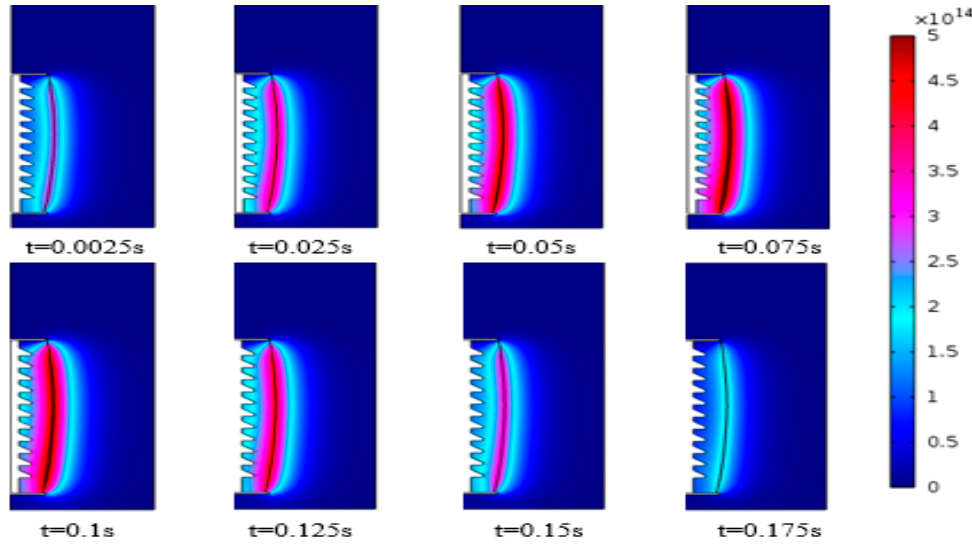
Figure 6. Electron density distribution at different times.